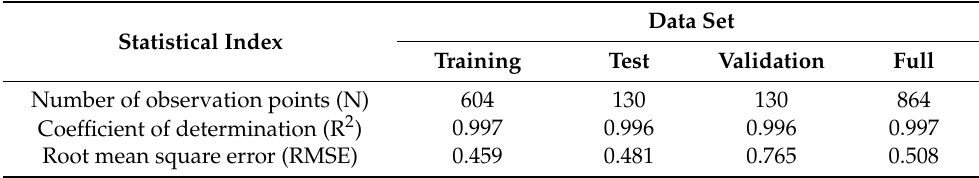
Table 7. Indicators used to evaluate the performance of the ANN-MLP model of water–fat serum release from pasta filata cheese.